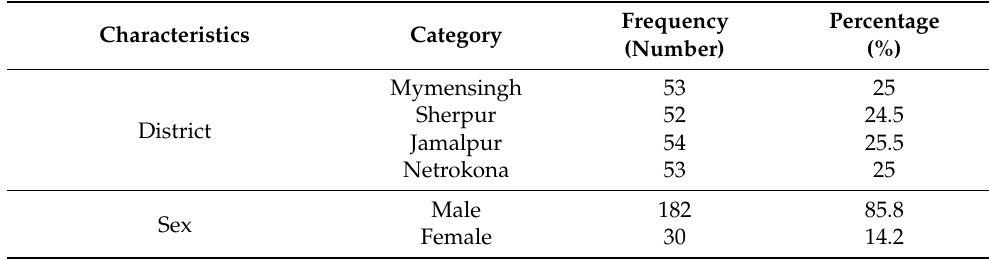
Table 1. Demographic and socio-economic characteristics of large-animal farmers (n = 212) in the study